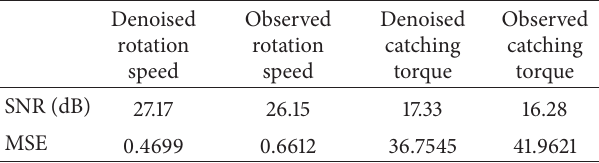
Table 8: The SNR and MSE of denoised signal and observed data.